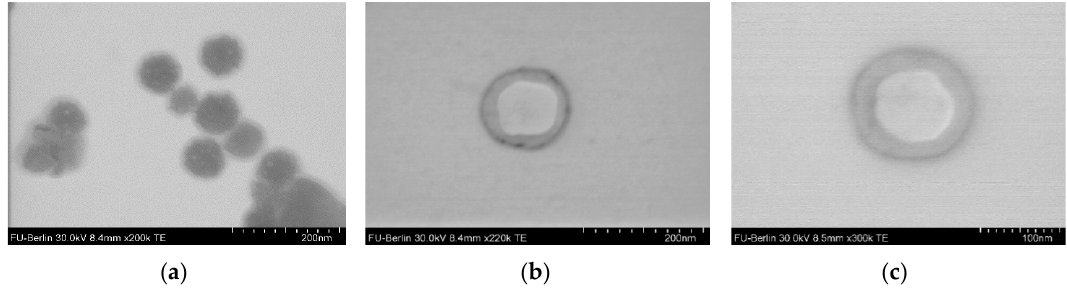
Figure 8. STEM images of nanoparticles based on ( a ) PMAG- b -PGlu(OBzl) (sample b5 ) and ( b , c )